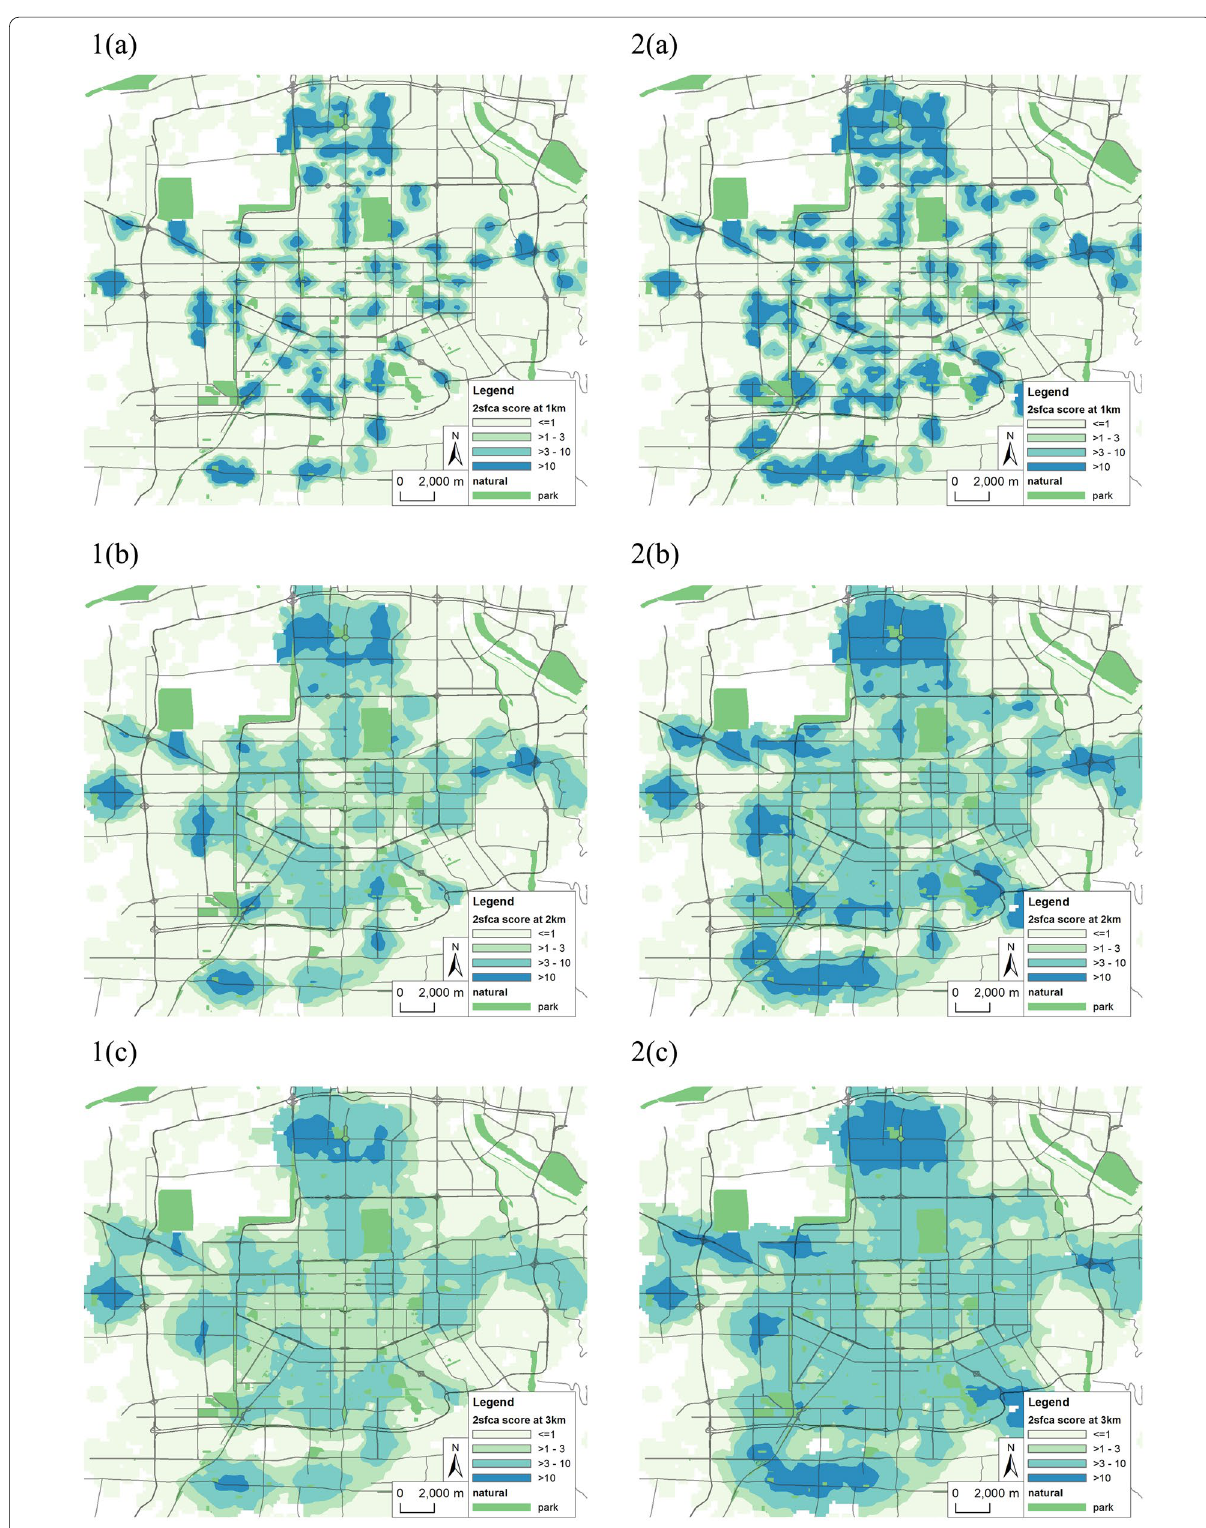
Fig. 6 Accessibility analysis of two batches of ESPs with different distances of 1000, 2000, 3000